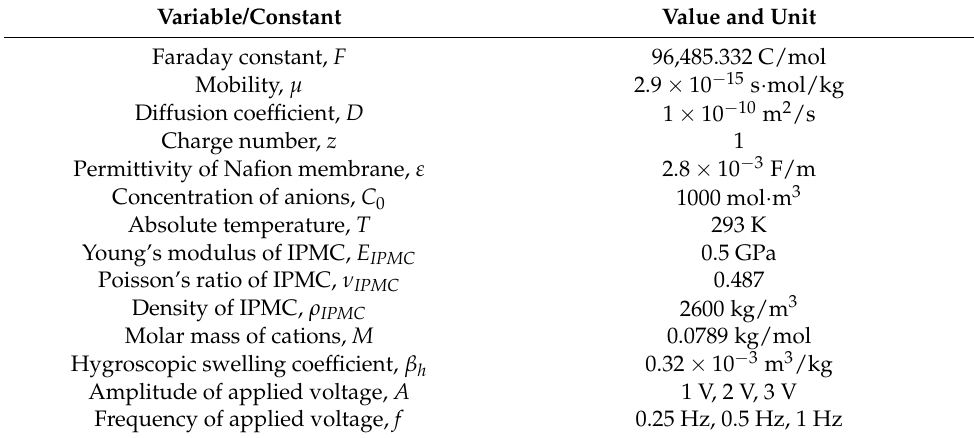
Table 2. Related parameters of the model.